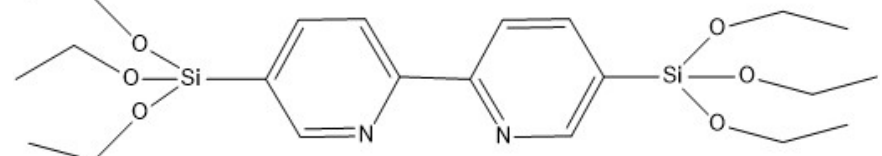
Figure 12. Chemical formula of the 5,5′-bis(triethoxysilyl)-2,2′-bipyridine (Etbipy) precursor.